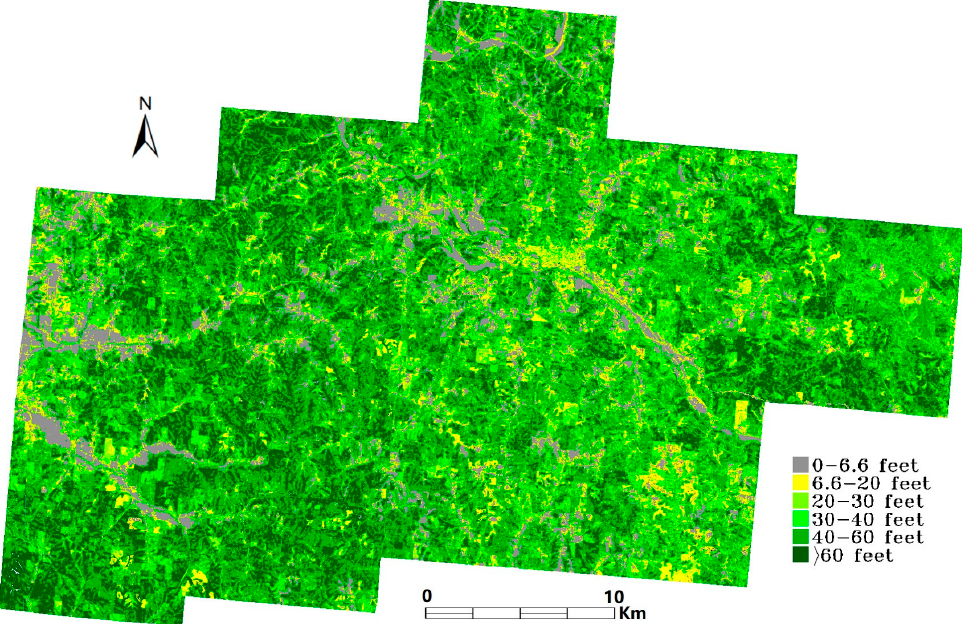
Figure 6. Canopy height estimated from LiDAR data.